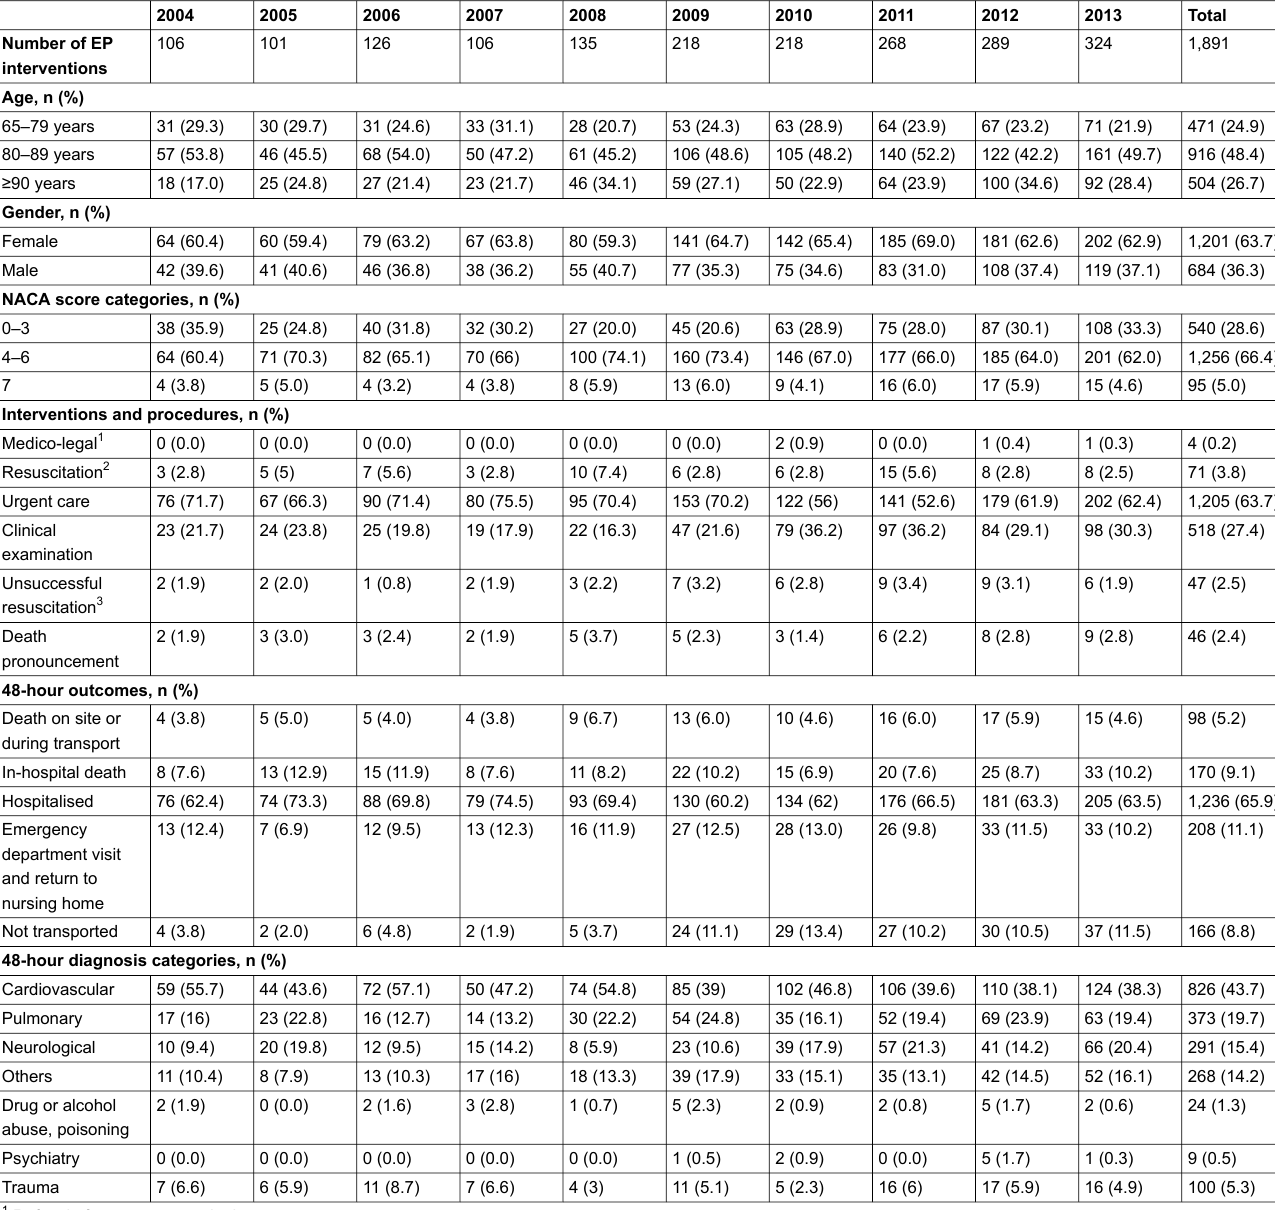
Table 3: Characteristics of emergency physician (EP) interventions for nursing home residents aged 65 years and